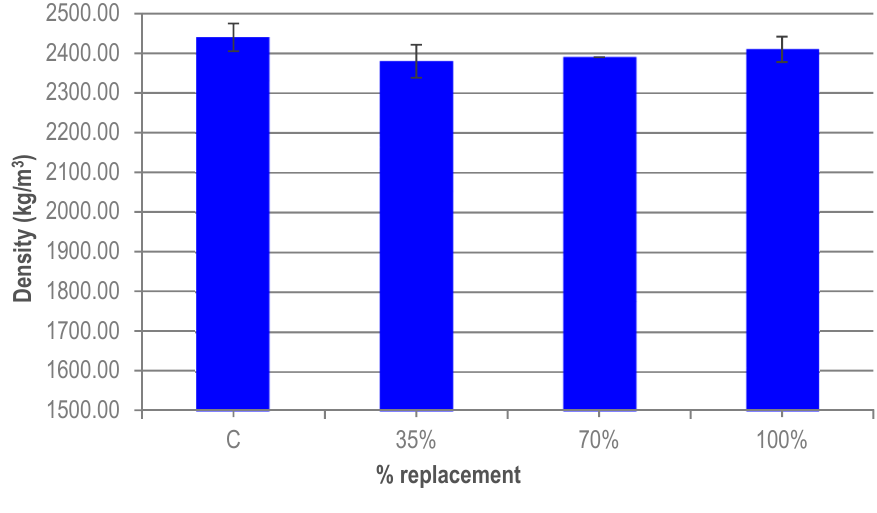
Figure 4. Density of UHPC.